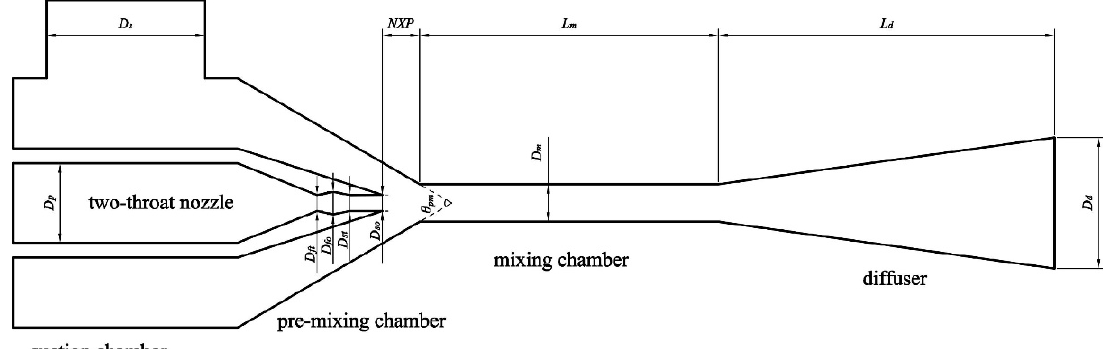
Figure 2. Structural diagram of the two-throat nozzle ejector. Table 1. Key structural sizes for the two-throat nozzle ejector.